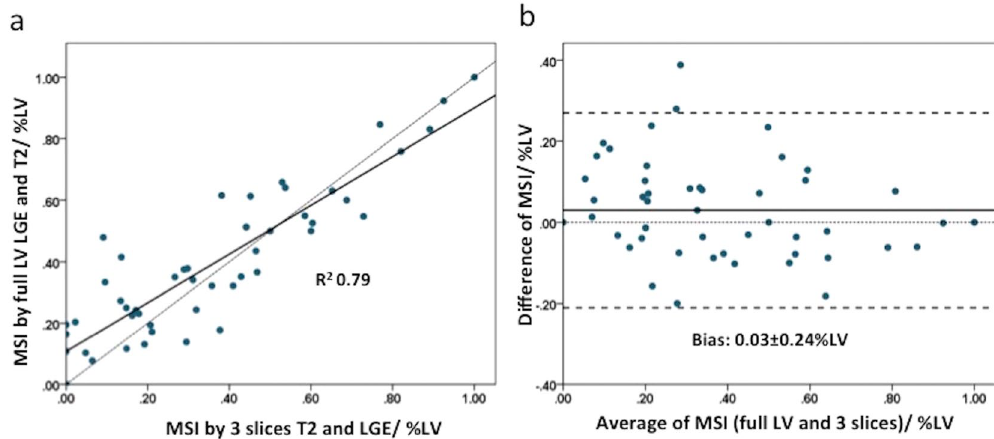
Figure 5. Performance of the full LV coverage versus 3-slice approach (both for the AAR and the MI size) for the MSI. ( a ) The correlation between the 2 approaches; ( b ) The Bland-Altman